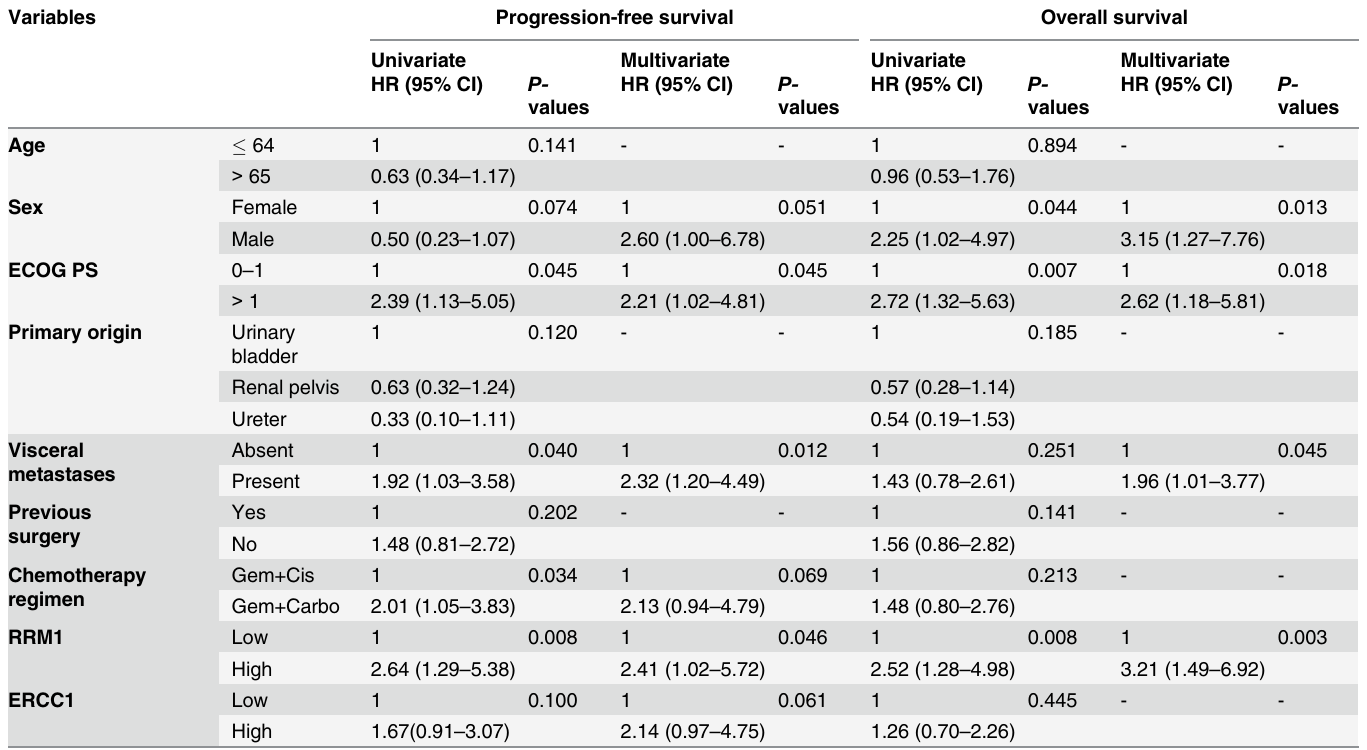
Table 4. Univariate and Multivariate Cox regression analyses for PFS and